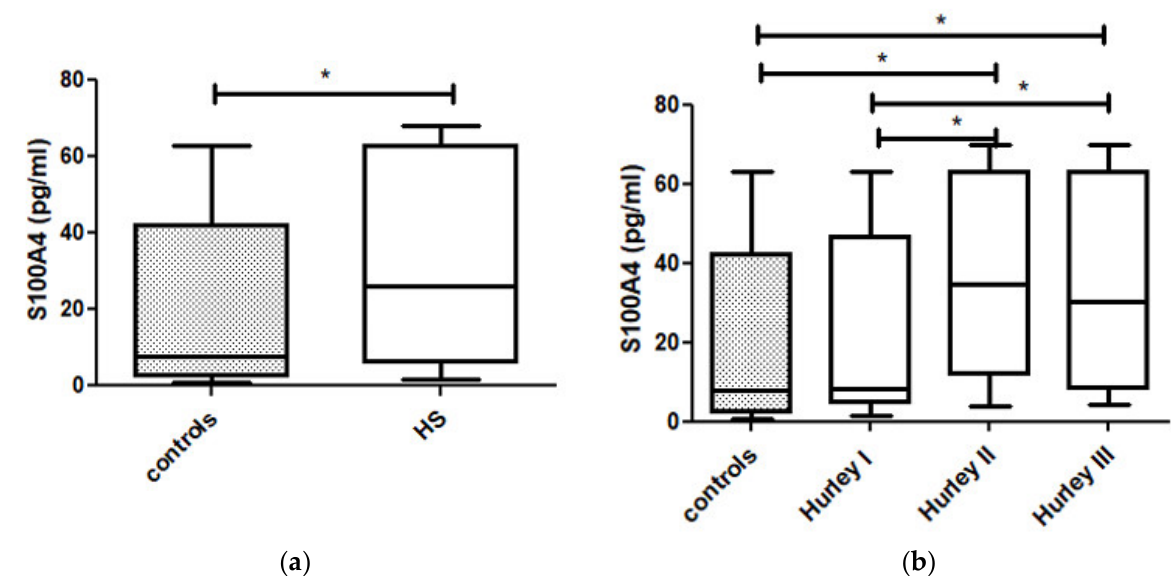
Figure 1. ( a ). The serum concentration of S100A4 in individuals suffering from HS was significantly elevated as compared to controls ( p = 0.022). ( b ). There was statistically significant difference in S100A4 serum concentrations between Hurley stages ( p = 0.03), with the highest concentration of S1004 in patients in Hurley II stage. The serum concentrations of S100A4 in patients in Hurley II stage was significantly elevated as compared to controls and individuals with HS in Hurley I stage ( p = 0.005, p = 0.012, respectively). The serum concentrations of S100A4 in patients in Hurley III stage was significantly elevated as compared to controls and individuals with HS in Hurley I stage ( p = 0.039, p = 0.049, respectively). * is statistically significant result p < 0.05. Table 2. Serum levels of S100A4, S100A15 and C-reactive protein (CRP) in healthy controls and patients with hidradenitis suppurativa, according to Hurley staging system.